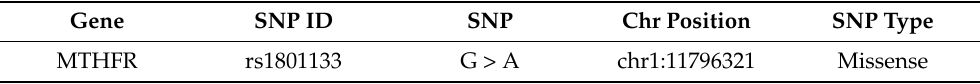
Table 1. SNP ID, position, and genotyping data based on the whole cohort (N = 160). Gene SNP ID SNP Chr Position SNP Type MTHFR rs1801133 G > A